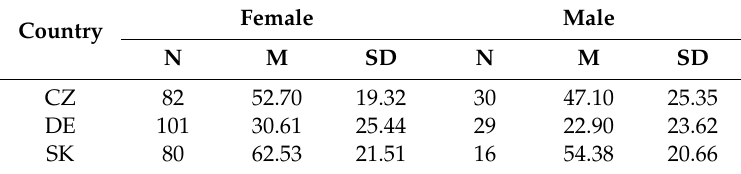
Table 2. Fear to become infected with COVID-19 during psychotherapy in personal contact 1 with respect to country (Czech Republic (CZ), Germany (DE), Slovakia (SK)) and gender in